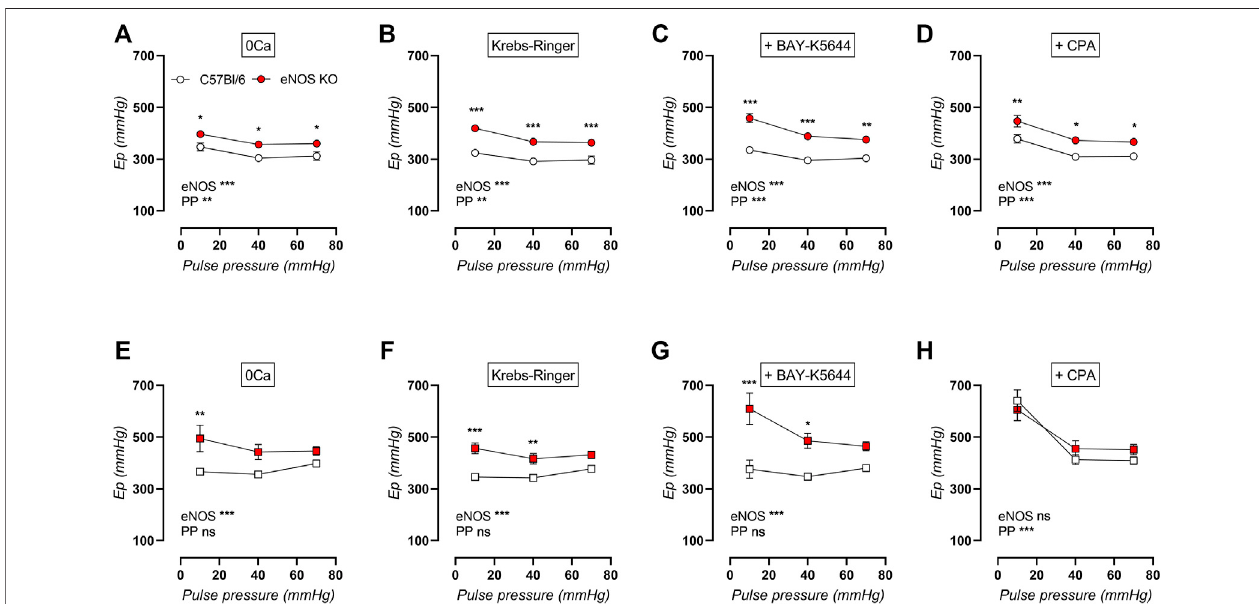
FIGURE11| Cyclicstretch-dependencyofbaselineaorticstiffnessisbetterpreservedwithageineNOSknockoutmice.Aorticringsofyoung(4 months, n =6)and aged (13 months, n = 4) eNOS knockout and young (4 months, n = 6) and aged (14 months, n = 4) C57Bl/6 control mice were subsequently exposed to 5 min of cyclic stretch at low (10 mmHg), physiological (40 mmHg), and high (70 mmHg) pulse pressure (PP). Aortic stiffness of young (circles, (A – D) ) and aged (squares, (E – H) ) mice wasmeasured in 0Ca Krebs-Ringer solution (A,E) , normal Krebs-Ringer solution (B,F) , inthe presence of30 nM BAY-K8644 (C,G) ,and in thepresence of10 µM CPA (D,H) . Statistical analysis was preformed using two-way ANOVA. Overall (bottom) and post-hoc (in graph) signi fi cance are listed. ns, p > 0.05; *, p < 0.05; **, p < 0.01; ***, p < 0.001.